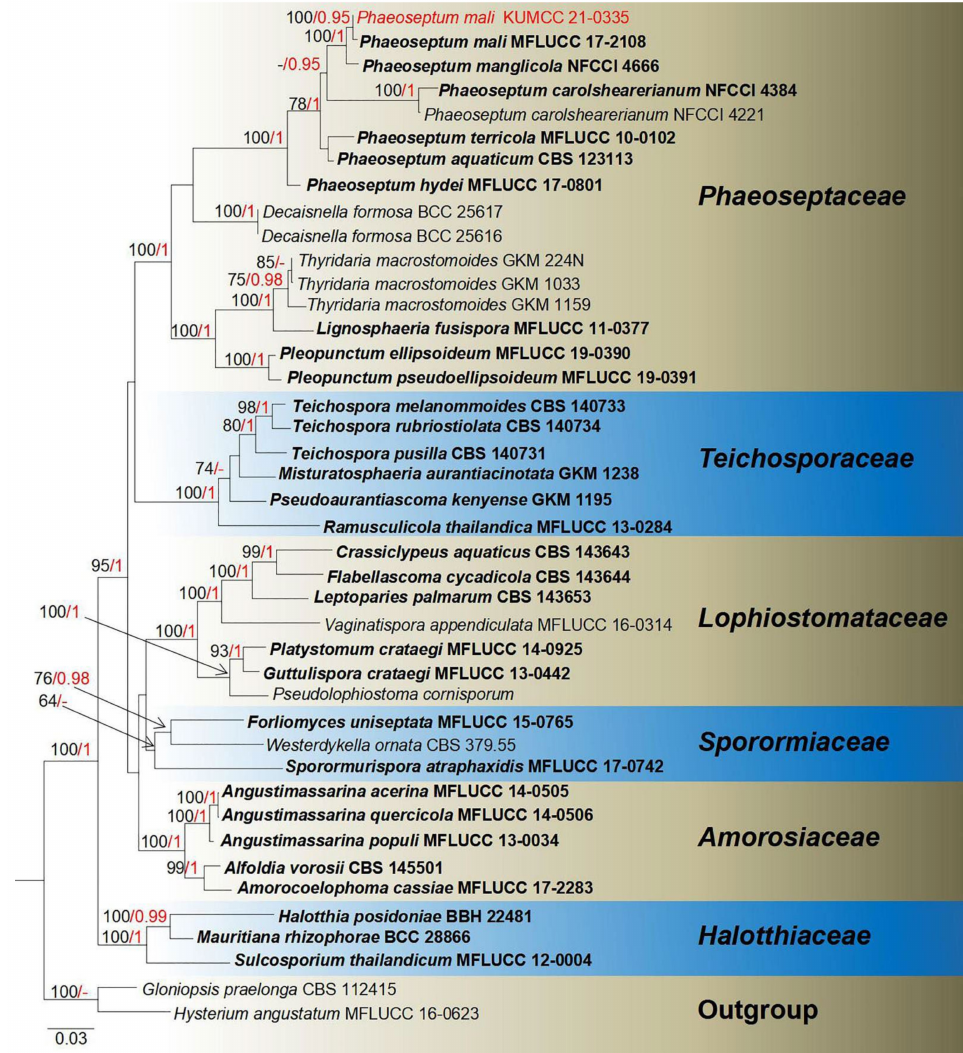
Figure 13. Phylogram generated from maximum likelihood analysis based on a combined LSU, SSU, ITS, and tef1- α sequence datasets. Related sequences were taken from Phukhamsakda et al. [65]. The 42 strains are included in the combined gene analyses’ 3348 total characters, including gaps (LSU: 1–848 bp, SSU: 849–1874 bp, ITS: 1875–2427 bp, tef1- α : 2428–3348 bp). Tree topology of the ML analysis was similar to the BI. The matrix had distinct alignment patterns, with the final ML optimization likelihood value of − 20,978.655356 (ln). All free model parameters were estimated by RAxML model, with 1323 distinct alignment patterns and 24.92% undetermined characters or gaps. Estimated base frequencies were as follows: A = 0.239024, C = 0.256186, G = 0.275083, T = 0.229707, with substitution rates AC = 1.071457, AG = 2.395085, AT = 1.478858, CG = 1.122178, CT = 6.702940, GT = 1.000000. The gamma distribution shape parameter alpha = 0.570195, and the Tree-Length = 1.698997. The final average standard deviation of split frequencies at the end of total MCMC generations was calculated as 0.008933 in BI analysis. The species determined in this study are indicated in red. Bootstrap values greater than 60% (ML, left) and Bayesian posterior probabilities (BI, right) greater than 0.95 are given at the nodes; hyphens (-) represent values less than 60% in ML/0.95 in